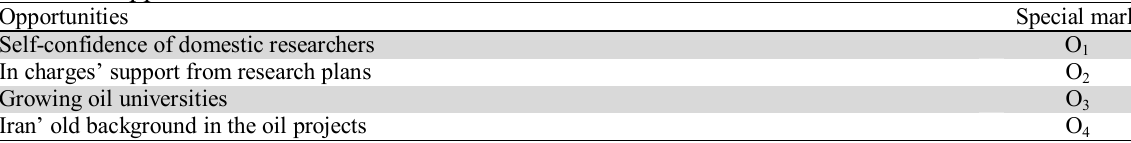
Fig. 1. The proposed model of opportunities and threatens in Pars Special Economic Energy Zone The extracted opportunities and threats were distributed among experts and specialists via questionnaire designed in order to determine the validity and evaluating. We then collect the questionnaires, the opportunities and threats approved by more than 70% of the specialists. Table 1 and Table 2 summarize the most important opportunities and threats. Identified opportunities